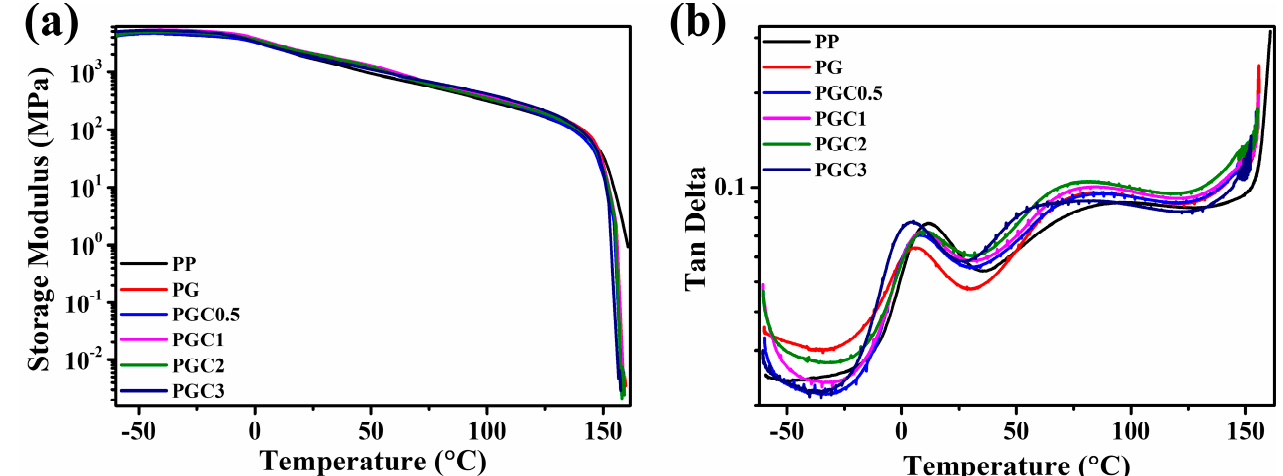
Figure 5. DMA cures of PP and the PP/DCP/GMA/C blends with different tea polyphenols (C) loading: ( a ) storage modulus and ( b ) loss tangent as a function of temperature.